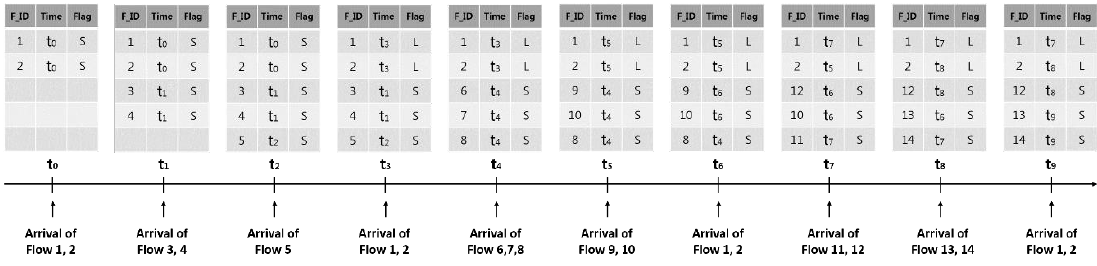
Figure 7. An example of updating the flow table using the SFF scheme.